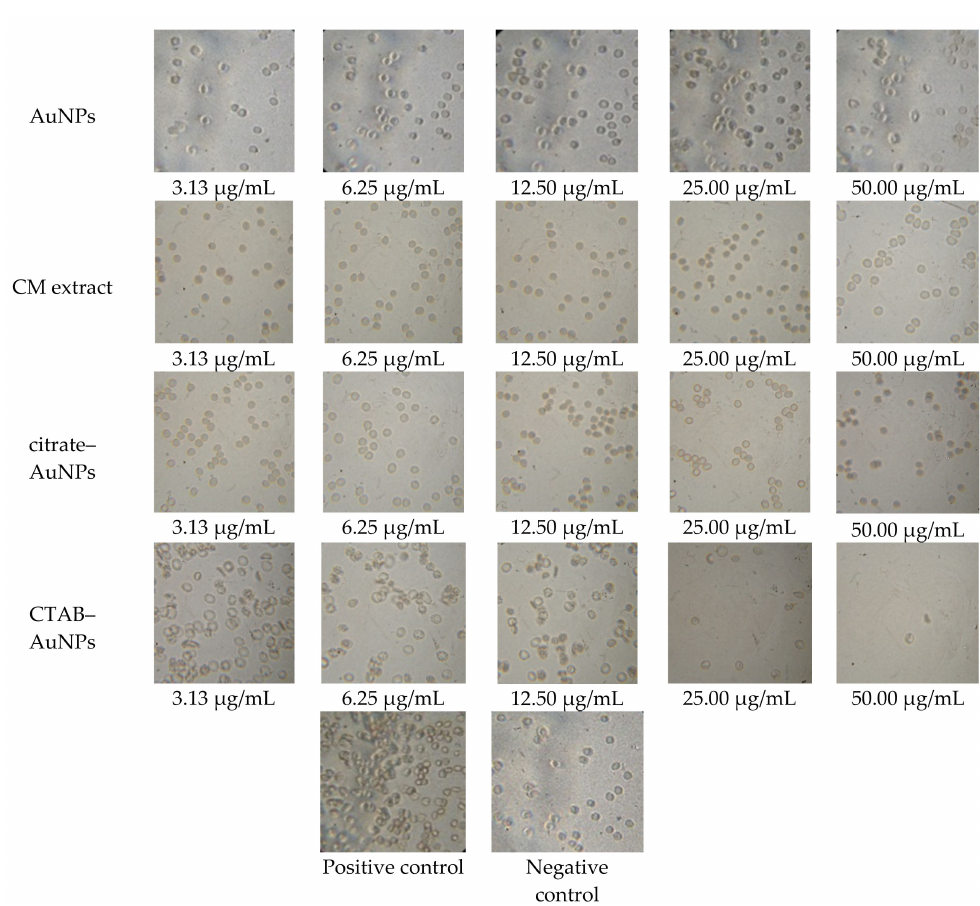
Figure 6. Percentage of hemolysis of red blood cells after exposure to AuNPs at concentrations of 3.13, 6.25, 12.50, 25.00, and 50.00 µ g/mL. Each point represents mean ± S.E., with n = 3 (if not indicated, the error bar was within the size of the symbol).